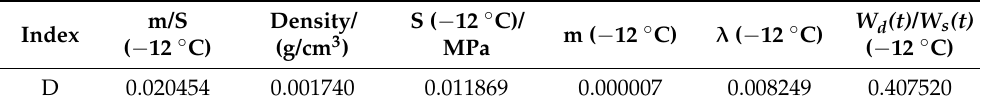
Table 6. Discrimination capability of low-temperature evaluation indexes.